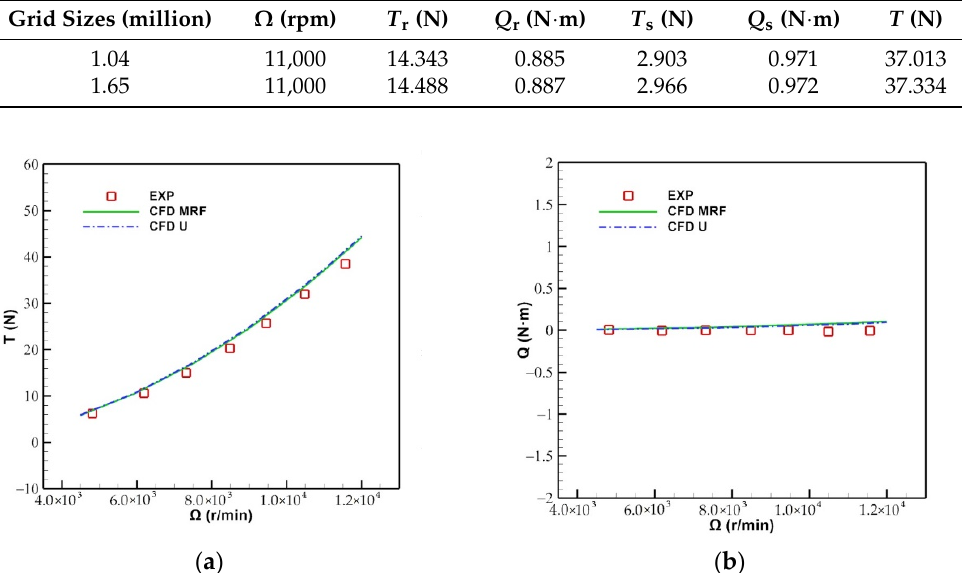
Figure 6. Comparison of the results between the experiment and CFD methods: ( a ) Total thrust, ( b ) total torque.